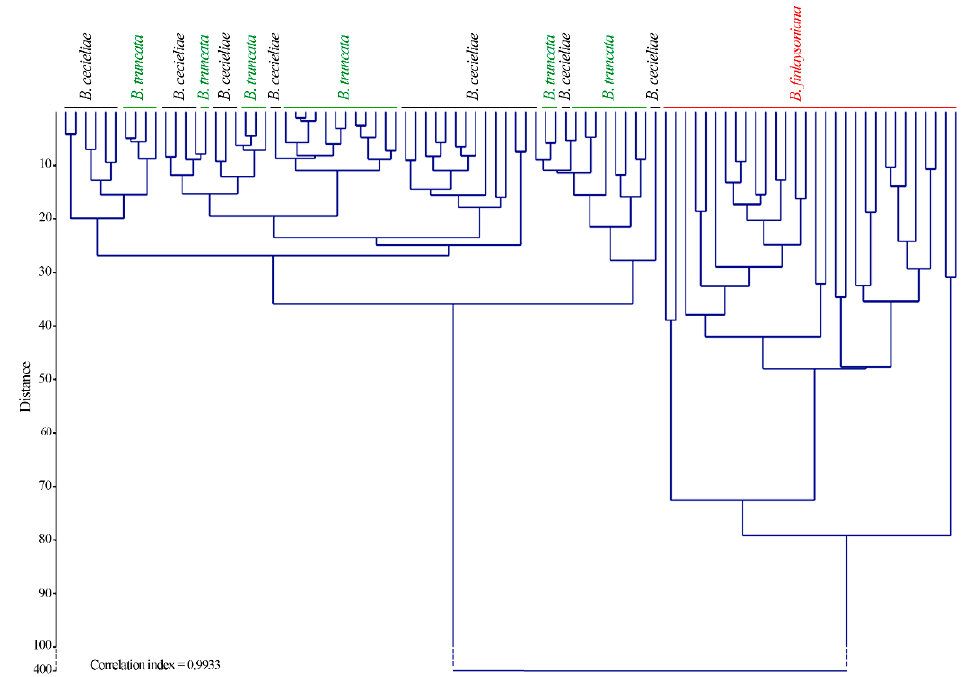
Figure 5. Dendrogram showing the clustering of the studied species of Bromheadia .